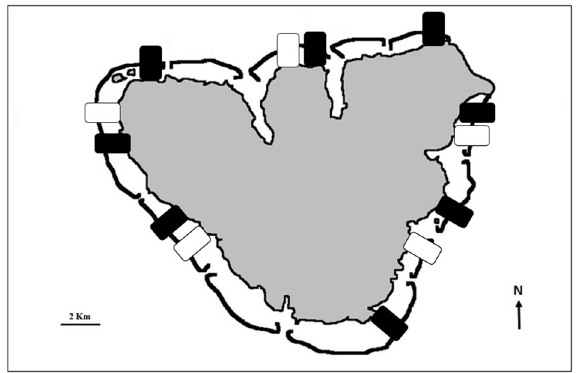
Figure 1. Map of Moorea Island, French Polynesia (drawn by the authors using PhotoFiltre 7 software [version 7.1.2—www. photo filtre. com]) and location of the 13 shallow reef flats (MPA sites—black rectangles; non-MPA sites—white rectangles) used in this